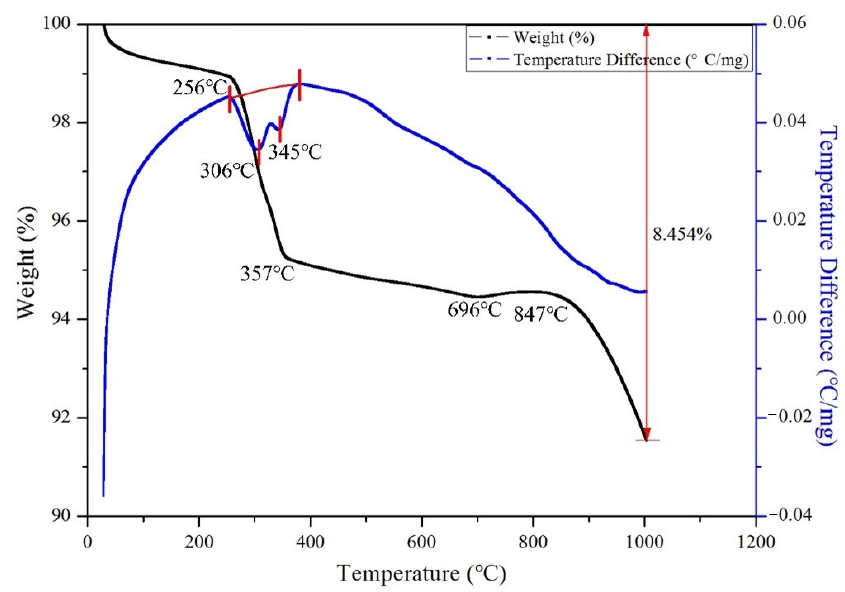
Figure 4. TG-DTA analysis result of the zinc calcine (DZC-1).